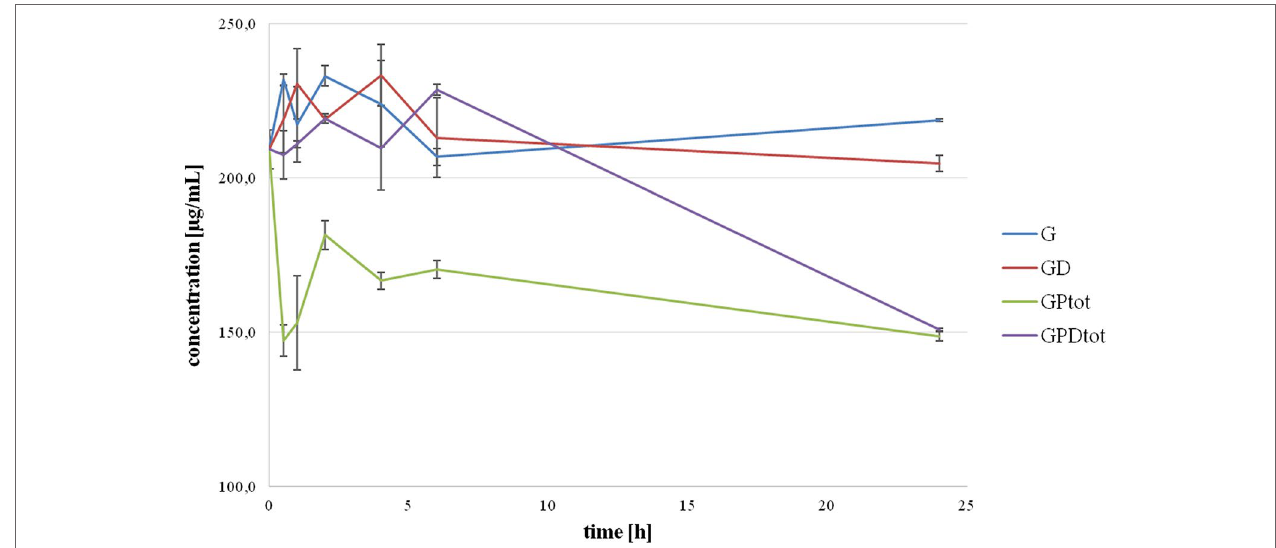
FIGURE 3 | Total concentration of gliclazide as a sum of intracellular and extracellular concentration during incubation with probiotics without the presence (GPtot) and in the presence of deoxycholic acid (GPDtot) compared with their control groups (G) and (GD),